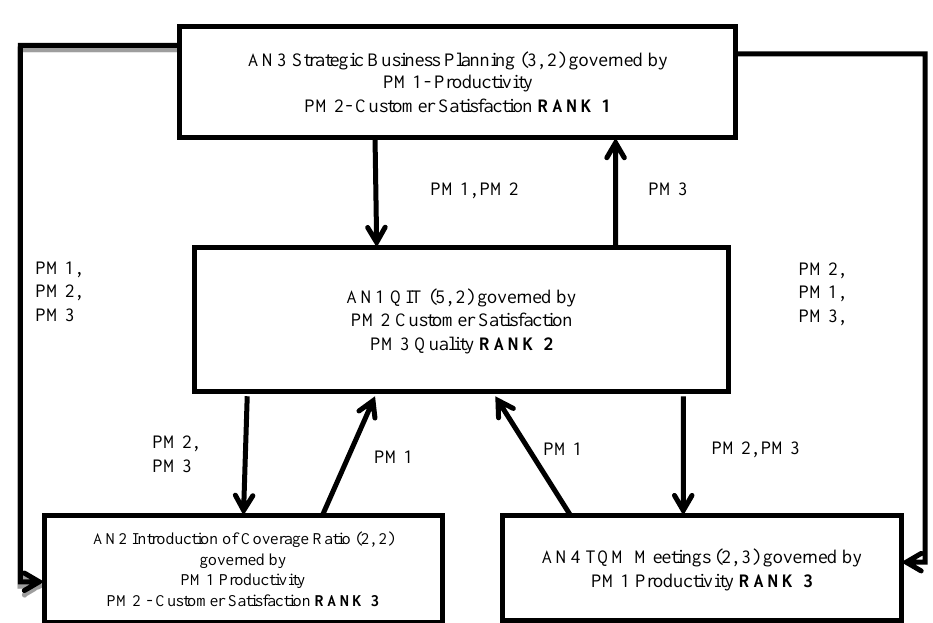
Figure 2. IRP model for actions with reference to